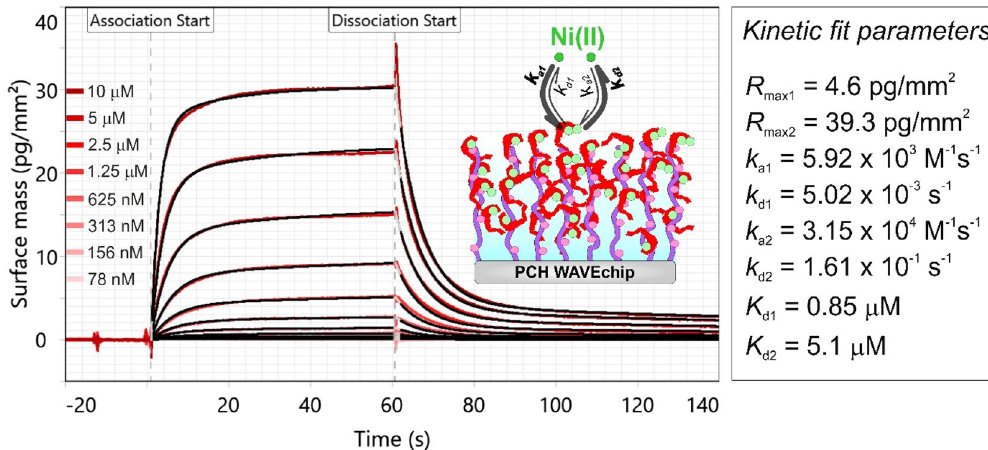
Figure 6. Measured kinetic data of Ni(II) binding obtained at high FliC-NikR C coverage on a PCH WAVEchip (red curves). The shown measurement curves were adjusted and represent Ch1 - Ch2 reference corrected data. The data were fitted using the heterogeneous ligand kinetic model (black curves). The inset scheme illustrates the binding of Ni to the FliC-NikR C monomers which were immobilized on the thick hydrogel coating of the PCH chip. The light green circles represent Ni(II) ions bound to LA sites.